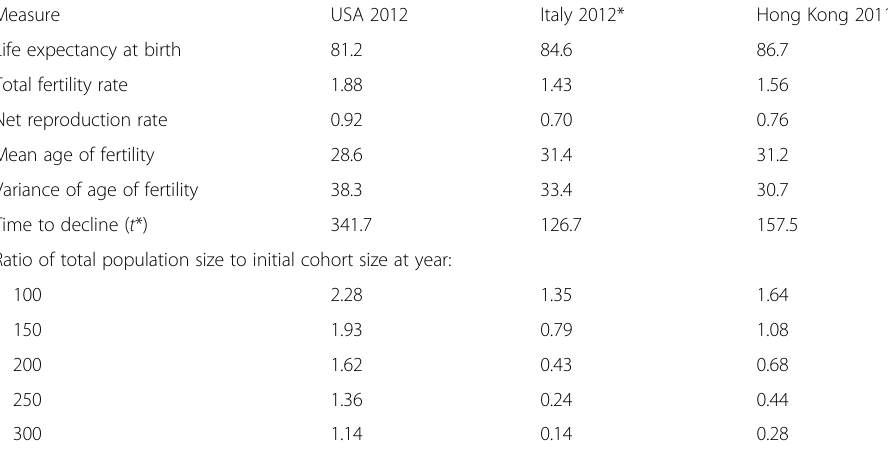
Table 3 The time to decline based on observed rates in three contemporary populations Measure